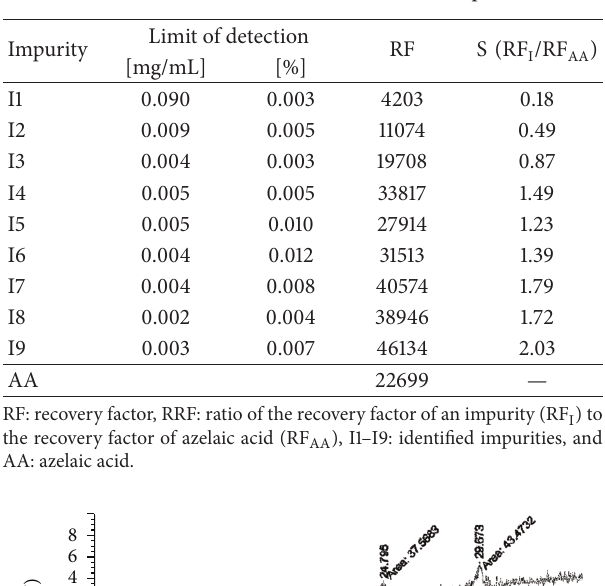
Table 2: Results of the evaluation of the precision of the system. Table 3: LODs and RRFs for the identified impurities.